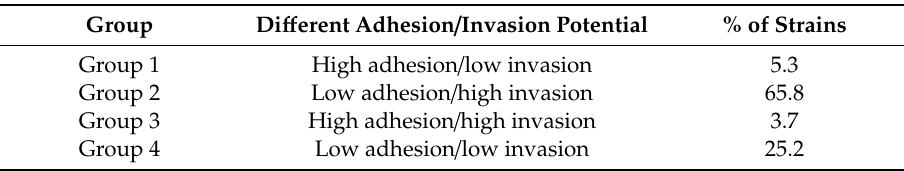
Table 1. Adhesion / invasion capacity of the C. jejuni